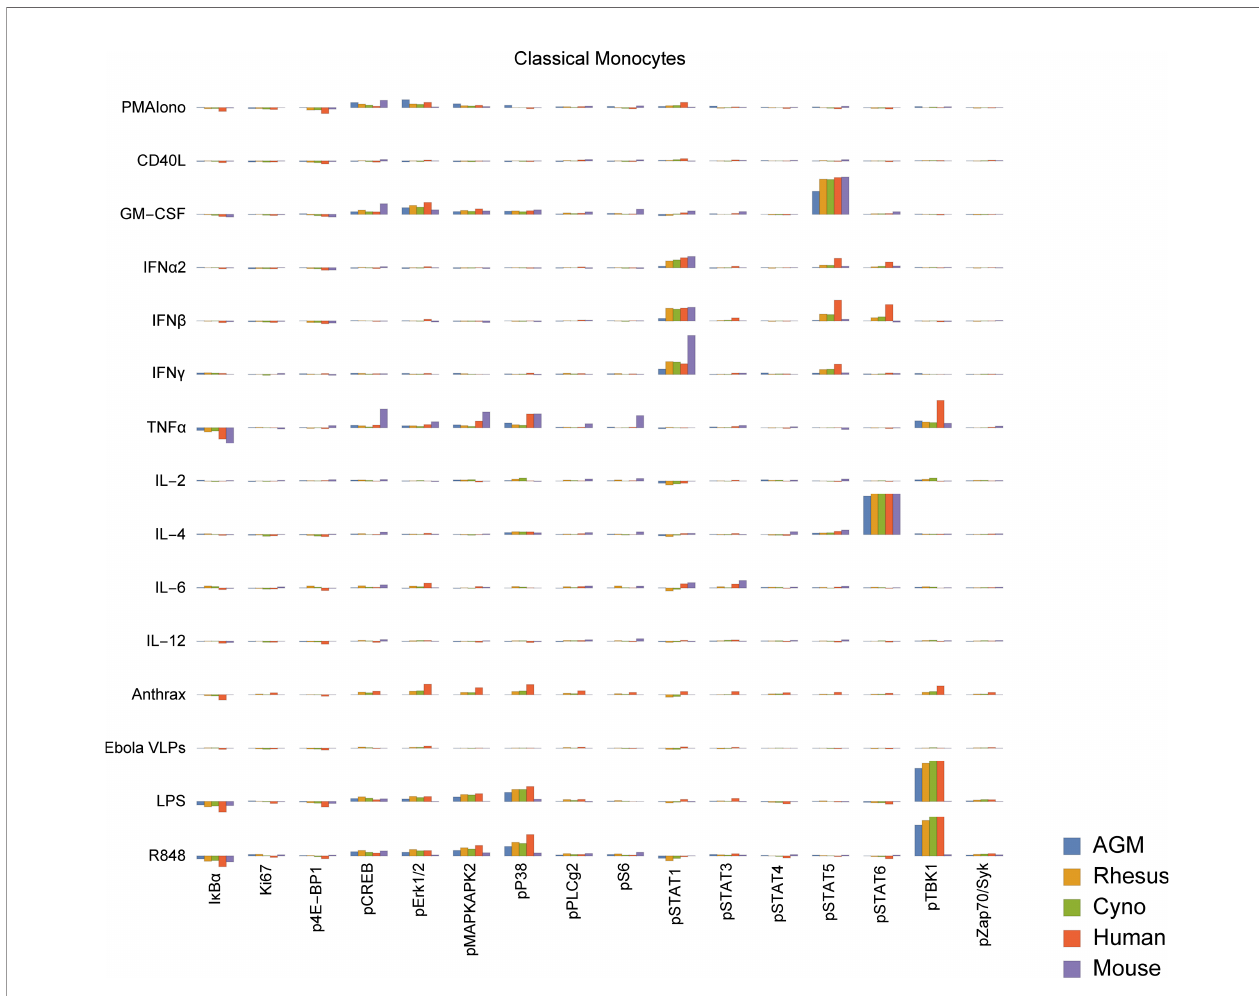
FIGURE 5 | Signaling responses (difference of ArcSinh-transformed values; approximately equivalent to fold-change) in classical monocytes by stimulus, activation marker and species (other cell types in Figure S4 ). Note that Bacillus anthracis ( “ anthrax ” ) and Ebola VLPs were not available for use as stimuli in mice or AGMs; thus, values for these species are always displayed as zero. We could not gate intermediate monocytes or a “ CD11b − /CD16 − ” -equivalent population in mice; these values are also zero. The Y axis range of all charts is -0.5 to